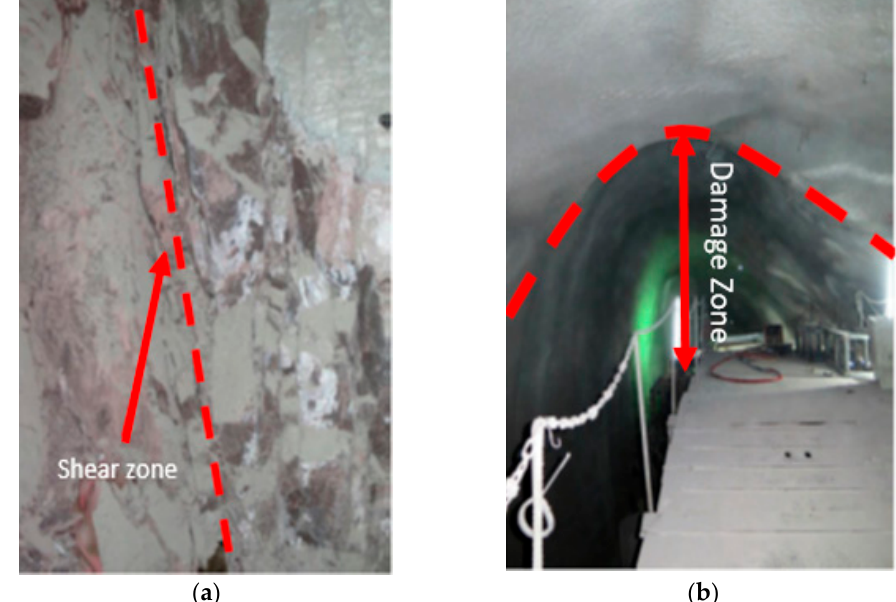
Figure 4. Shear zone and its impact: ( a ) exposure of the shear zone in the wall of Tunnel 696; ( b ) failure profile of damage in Tunnel 696.